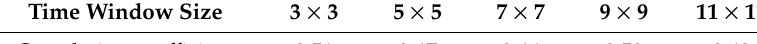
Table 7. Correlation coe ffi cient for di ff erent time windows after denoising based on VMDC. Time Window